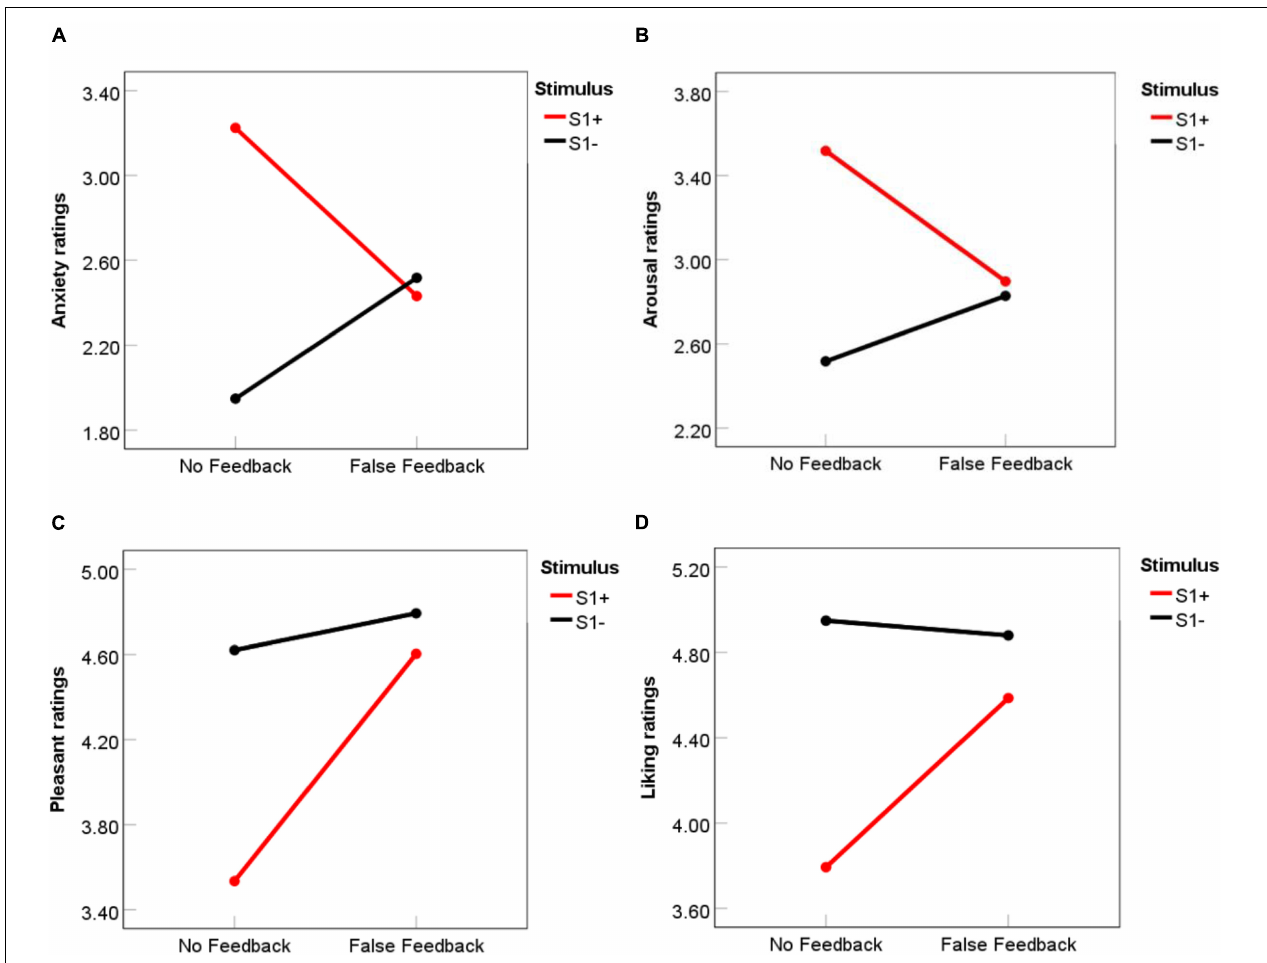
FIGURE 4 | Mean ratings of anxiety (A) , arousal (B) , pleasantness (C) , and liking (D) for S1 + and S1- in false feedback and no feedback conditions. Ratings ranged from 1 to 7. For Anxiety, 1 = not anxious at all, 4 (middle point) = moderate anxiety, 7 = very anxious; For Arousal, 1 = very calm, 4 = neutral, 7 = very aroused; for Pleasantness, 1 = very unpleasant, 4 = neutral, 7 = very pleasant; for Liking, 1 = very disliked, 4 = neutral, 7 = very